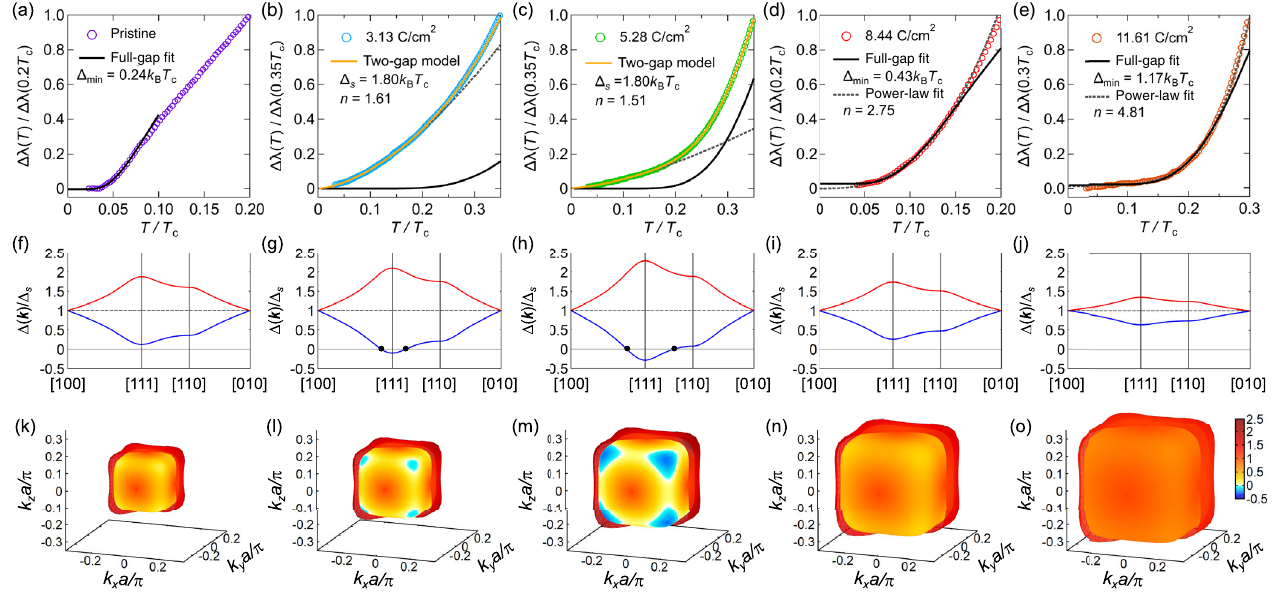
FIG. 3. Evolution of penetration depth and superconducting gap structure with electron irradiation. (a) – (e) Δ λ ð T Þ normalized by the or 0 . 35 T for (a) pristine, (b) 3.13, (c) 5.28, (d) 8.44, and (e) 11 . 61 C = cm 2 irradiated samples. Open circles are value at 0 . 2 T c c experimental data, and black solid and dashed lines in panels (a), (d), and (e) are fitting curves in the fully gapped and power-law models, respectively. Black solid and broken lines in panels (b) and (c) are the fully gapped and power-law components of the two-gap model described by Eq. (2), respectively. (f) – (j) Momentum direction dependence of the normalized superconducting gap in the pristine and = Δ irradiated samples derived from the effective k · p model in Eq. (1) and Δ p; s values calculated from the simple model described by max Eq. (3). Red and blue lines correspond to the gap size on the outer and inner FSs, respectively. Black circles represent the positions of nodes. (k) – (o) Corresponding three-dimensional superconducting gap structure in the pristine and irradiated samples. White lines in panels (l) and (m) represent the nodal